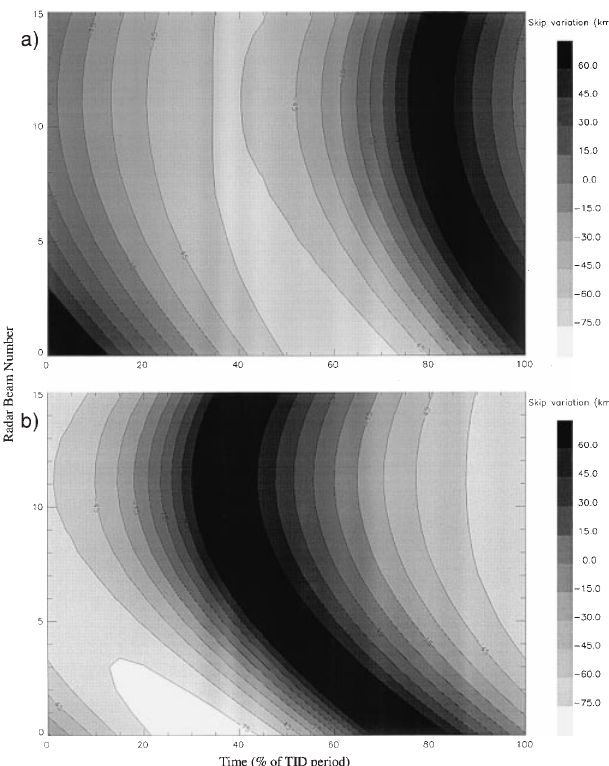
Fig. 8a, b. The modelled skip variation as a function of time and radar beam number (i.e. azimuth) for radar frequencies of a 9.97 MHz and b 12.4 MHz. Note that zero corresponds to a skip of 1090 km in a and 1420 km in b . The parameters used to model the TID are given in Table 2